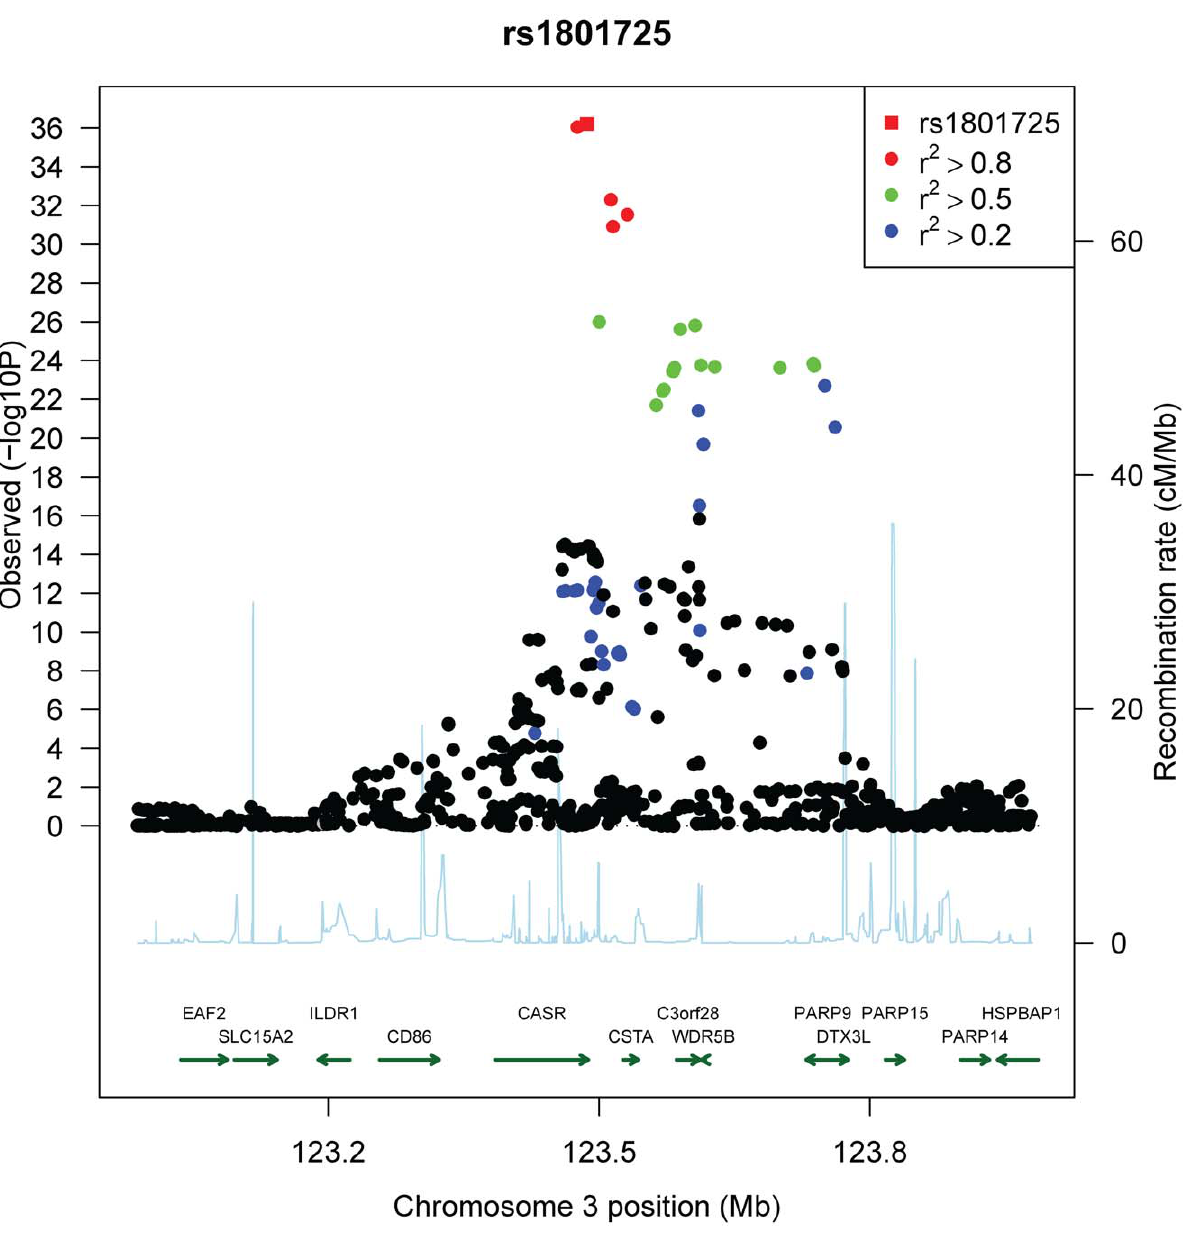
Figure 3. Regional association plot of the CASR locus. Plots show genomic position on the x-axis and 2 log 10 p-values on the y-axis for SNPs in the CASR locus on chromosome 3. The sentinel hit is shown as a red square. Patterns of linkage disequilibrium between the sentinel SNP and all other SNPs are color-coded. Red circles indicate high correlation (r 2 . 0.8), green circles indicate moderate correlation (r 2 . 0.5), blue circles indicate low correlation (r 2 . 0.2) and black circles indicate no correlation (r 2 , 0.2). The fine-scale recombination rates from [72–73] are plotted in light blue.